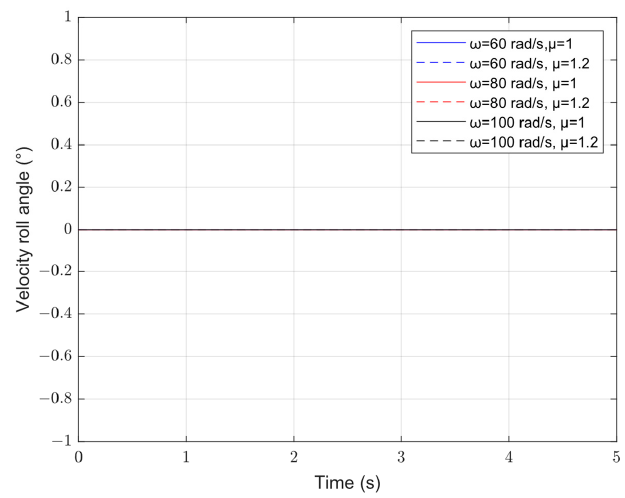
Figure 5. Response of Velocity Roll Angle.